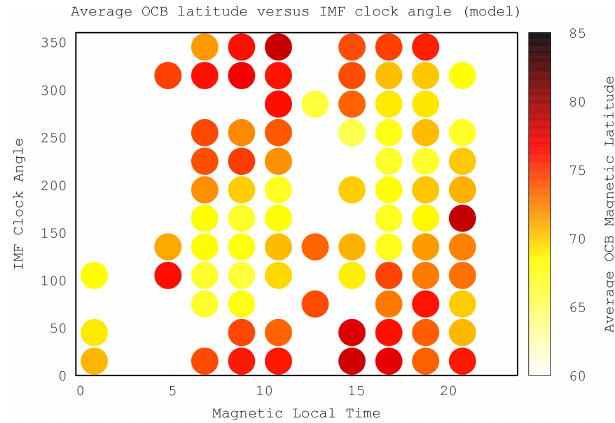
Figure 11. Scatterplot of MLAT versus IMF clock angle for the OpenGGCM results. The green curve is a fit to the data with a sim- ple cosine function.